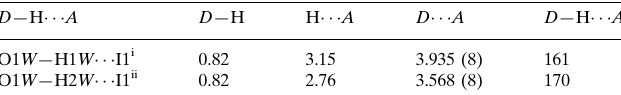
Hydrogen-bond geometry (A˚ , (cid:3)